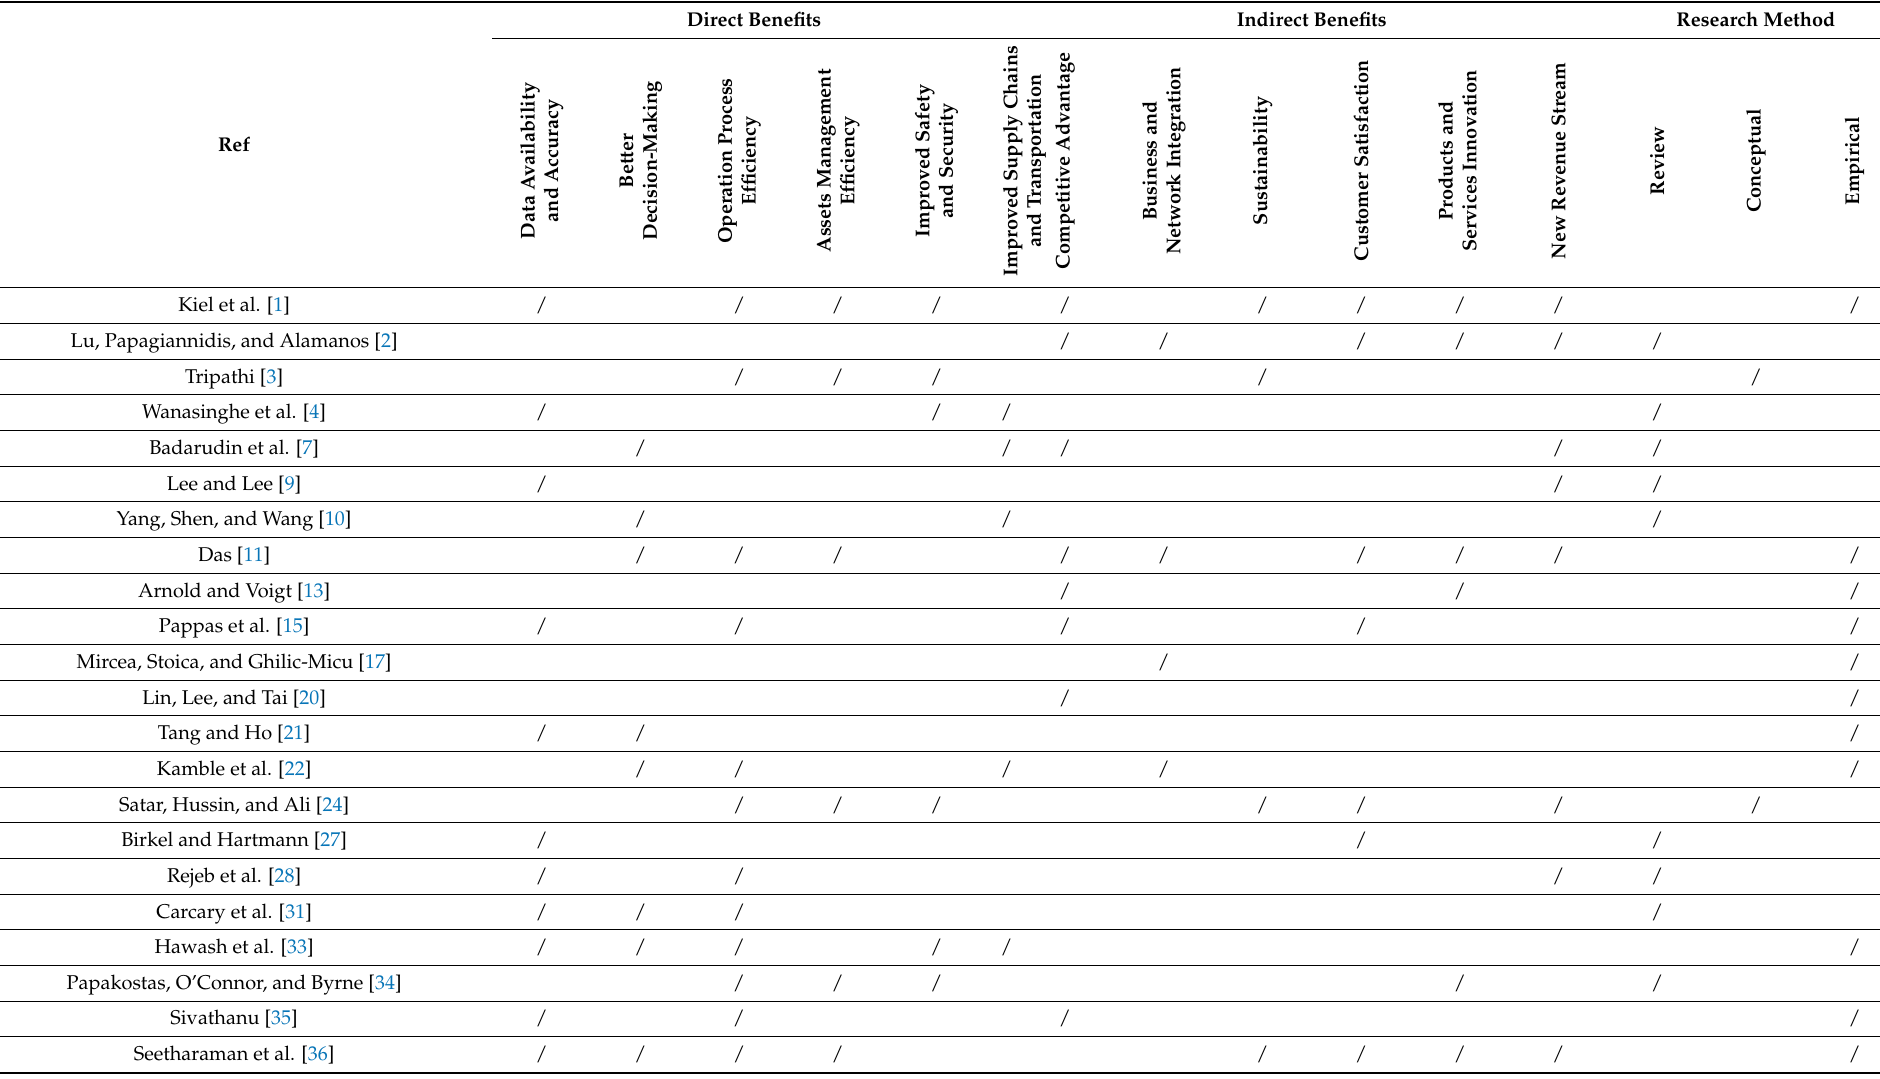
Table A2. Summary of IoT adoption